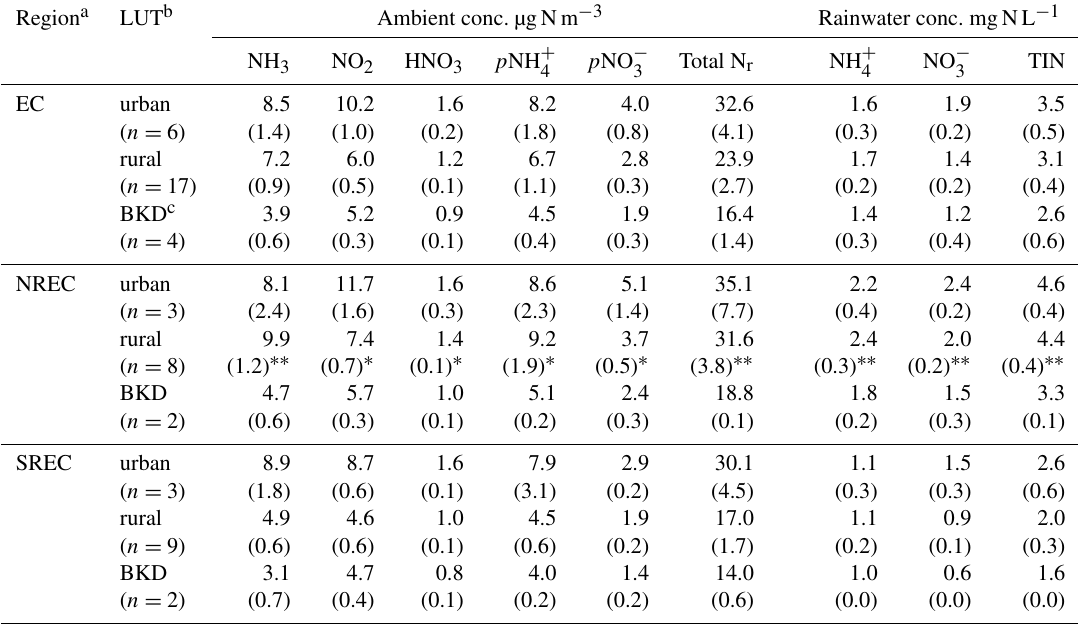
Table 1. Annual average (standard error) concentrations of various N r compounds in air and precipitation at different land use types in eastern China and its northern and southern regions for the 5-year period